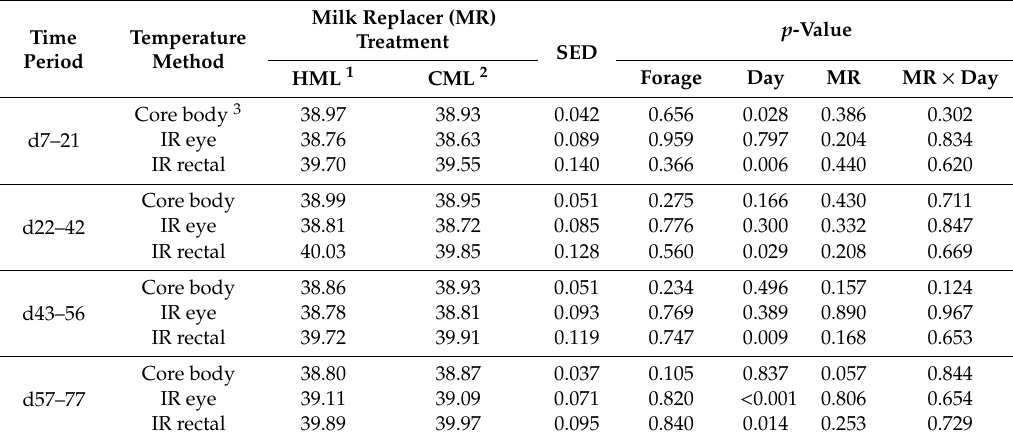
Table 5. Average core body, infrared (IR) eye and IR rectal temperature of calves managed under di ff erent nutritional regimes throughout the experimental period.